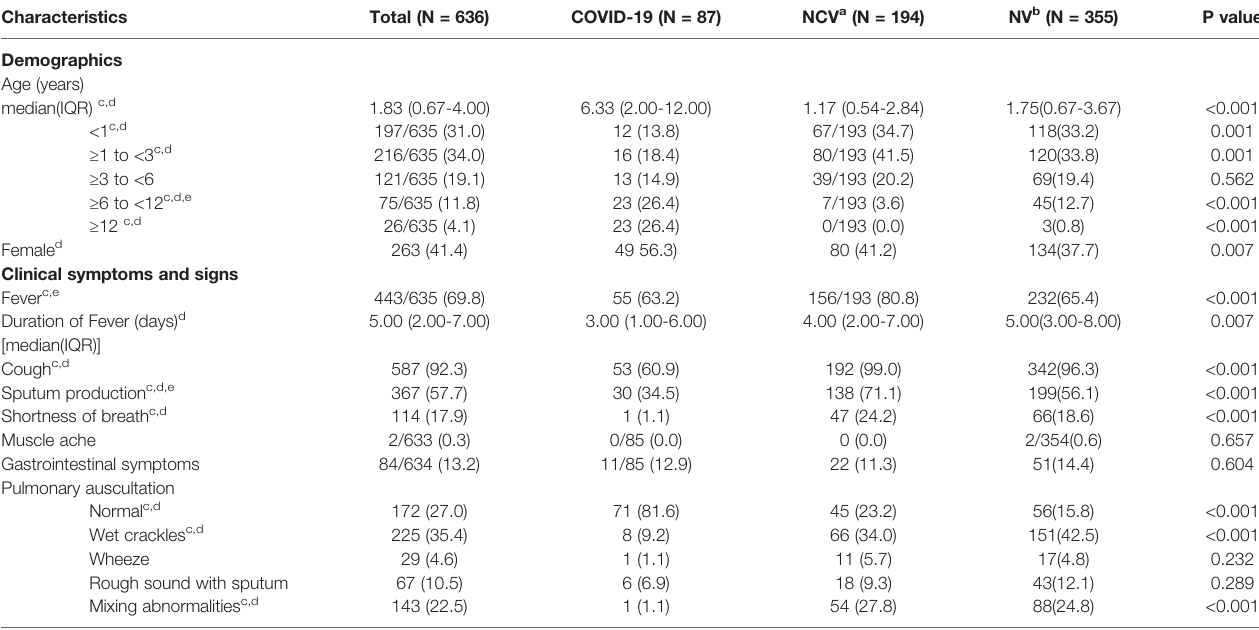
TABLE 1 | Demographic and clinical characteristics of patients among the three pneumonia groups.